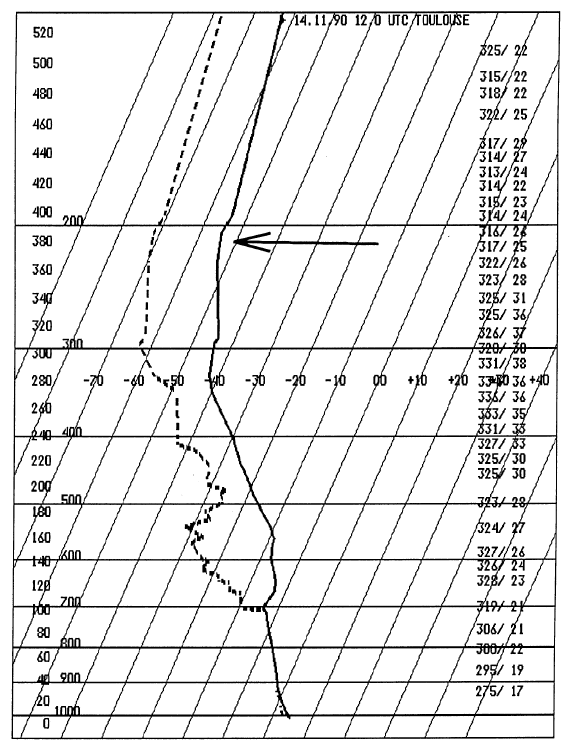
Fig. 8. Same as Fig. 7, but for 14 November, 12:00 UT at